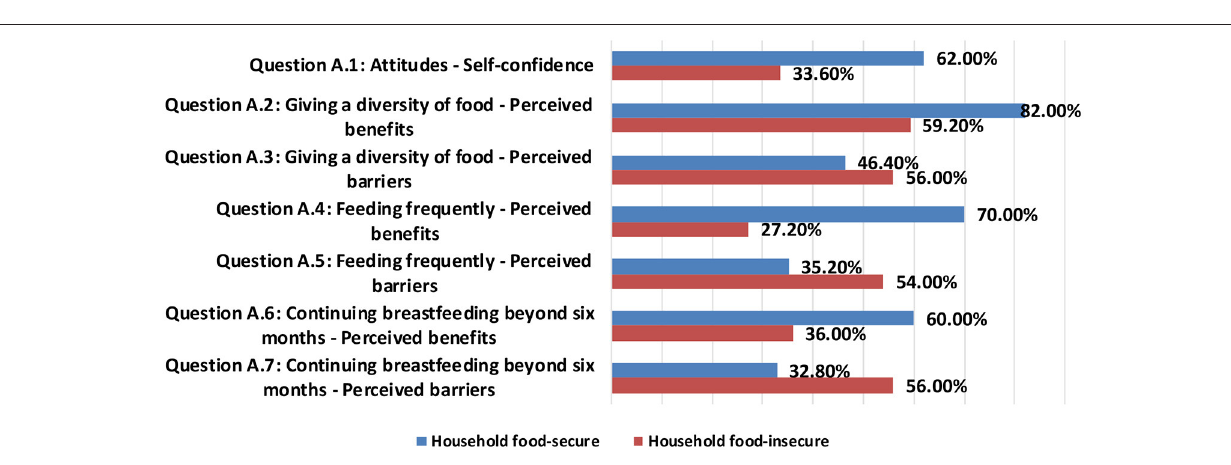
FIGURE 2 | Nutrition-related positive attitudes among household food-secure and household